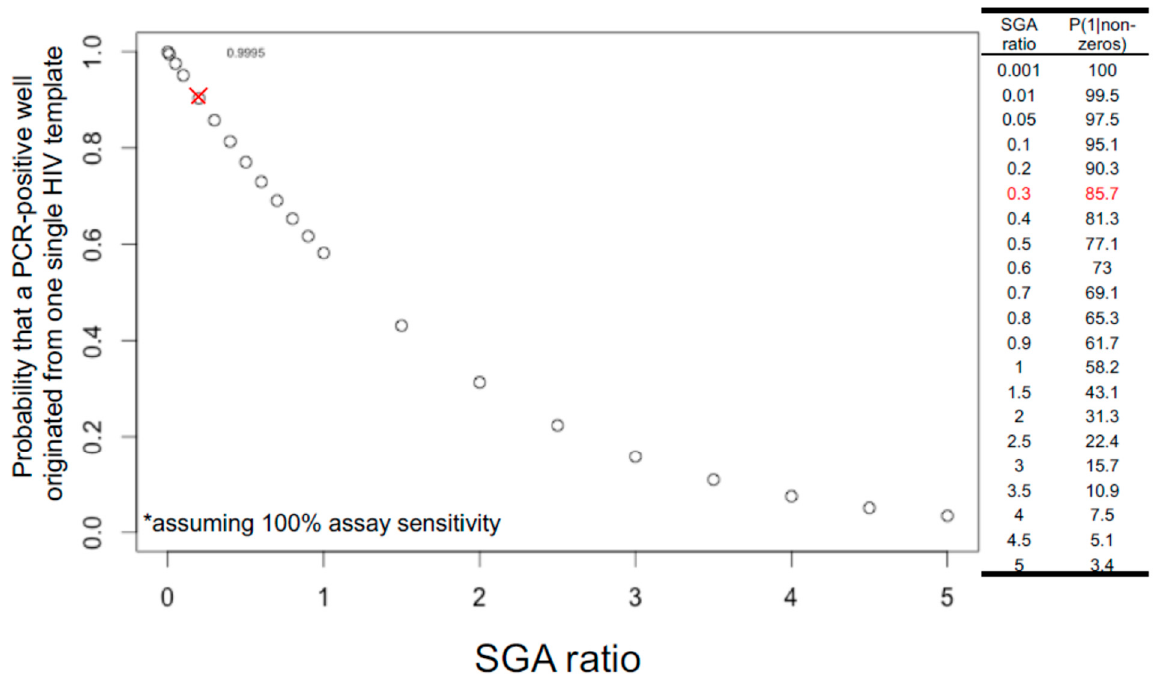
Figure 2. Probability that a PCR-positive reaction originated from one single HIV template follows Poisson probability distribution and decreases as SGA ratio increases. SGA ratio (x-axis) is defined as the number of expected positive reactions divided by the total reactions. For example, if ddPCR short amplicon estimation shows that there are 3 HIV-DNA copies per microliter within a nucleic acid extract, to achieve a limiting dilution at 1:3 (0.3) SGA ratio, one microliter of this extract would be distributed into 9 PCR reactions equally, yielding a probability of 85.7% (y-axis) that a given positive well is derived from one single HIV template (red cross in graph and red highlight in table). This calculation assumes 100% assay sensitivity in the amplification and detection of all input templates (asterisk).